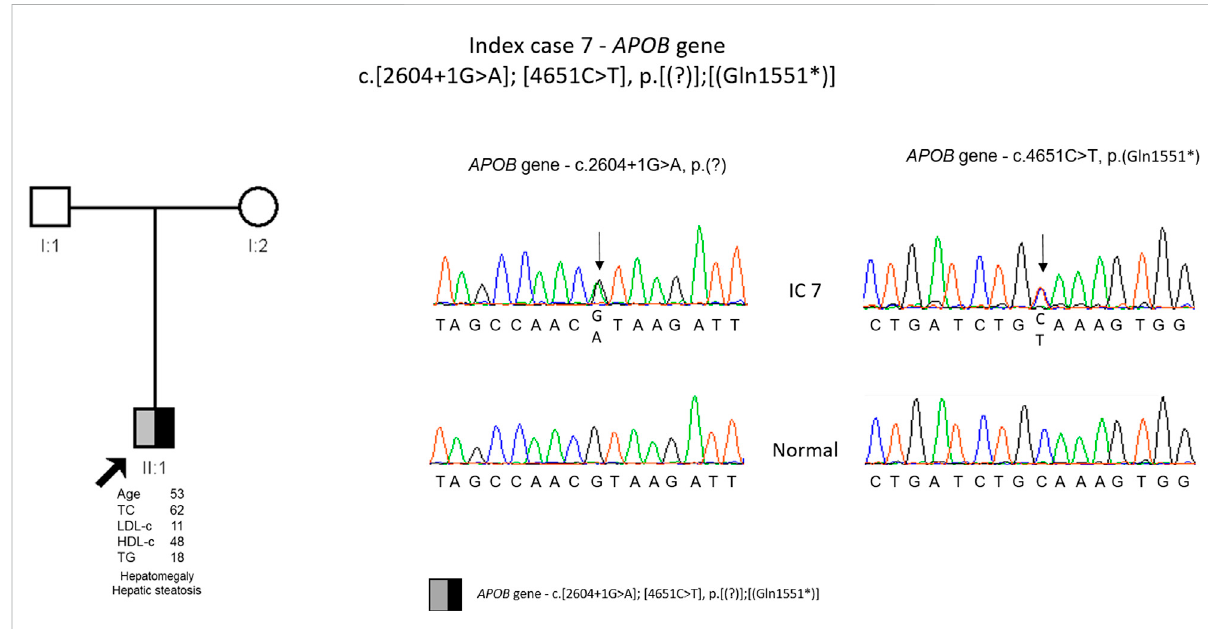
FIGURE 7 Arrow indicates index case 7 (IC7). Age (in years) and lipid pro fi le in mg/dL are under each symbol. Black half- fi lled symbol represent heterozygous individual for the variant in APOB gene, c.2604G > A, p.(?); Grey half- fi lled symbol represent heterozygous individual for the variant in APOB gene, c.4651C > T, p.(Gln1551*); Partial sequence APOB gene of IC7 and normal